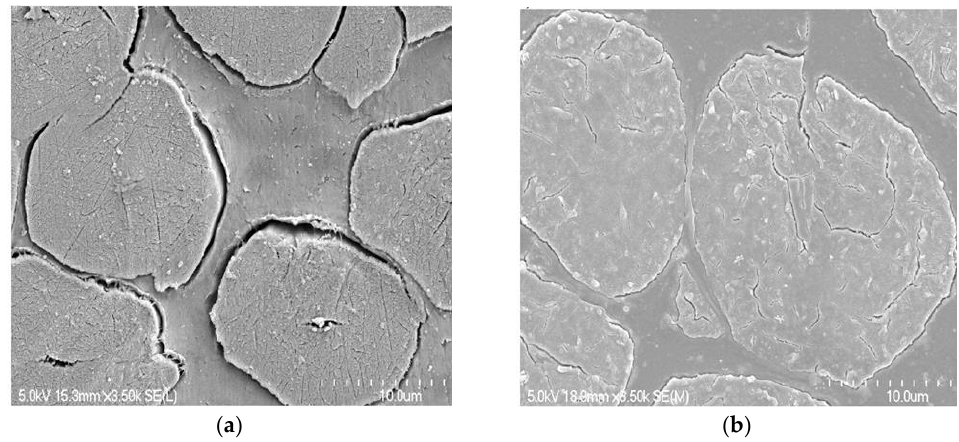
Figure 11. Cross-sectional area for ( a ) raw, ( b ) Oxidized – TiO 2 interphase modified flax fiber- reinforced composites. Reproduced with permission from [288]